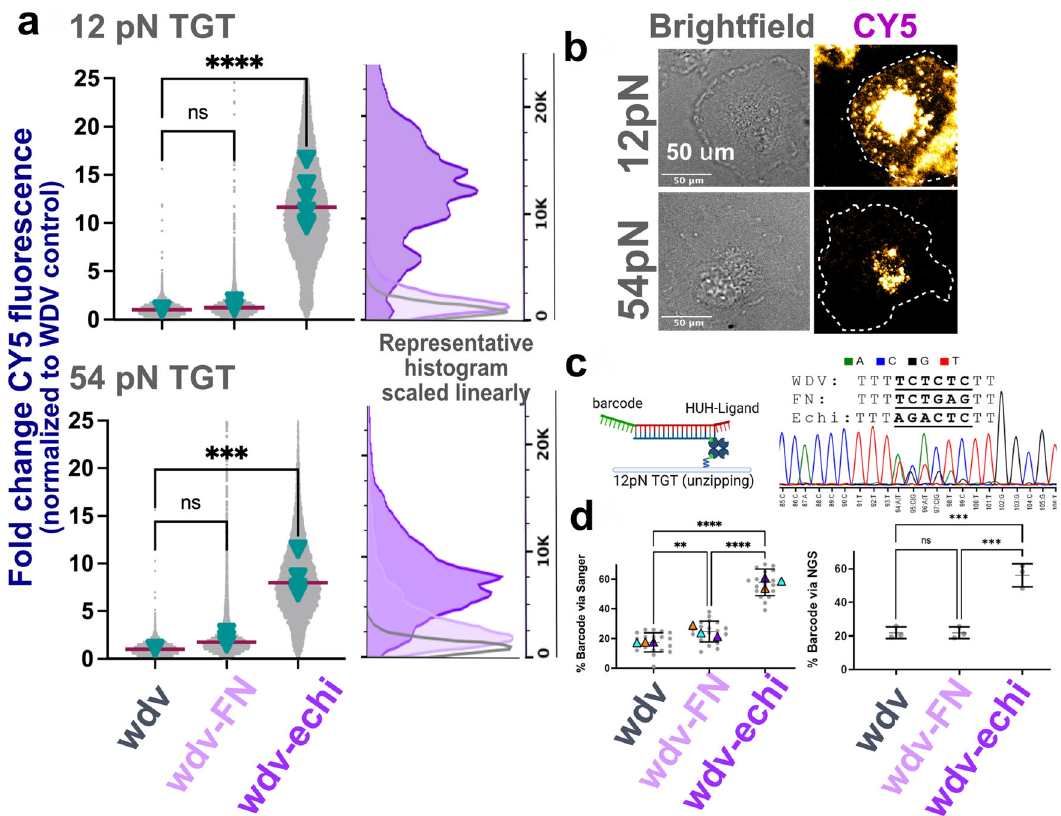
Fig. 2 | RAD-TGT measurements in U251 cells readout by fl ow cytometry and sequencingofinternalizedDNAbarcodes.a SuperPlotsofthefoldchangeofCY5 fl uorescence intensity of individual U251 cells plated on 12 pN (top) or 54 pN (bottom) RAD-TGTs with either WDV, WDV-FN, or WDV-Echi. Triangles represent themedianfoldchangeofpopulationperreplicate;thehorizontalredlineisatthe medianfoldchangeforallcellsanalyzed. n =8or5independentexperimentsfor12 pN and 54 pN graphs, respectively. *** p =0.0002, **** p <0.0001. b Bright fi eld and qTGT imaging of U251 cells plated on either 12 pN or 54 pN qTGTs with WDV-Echi